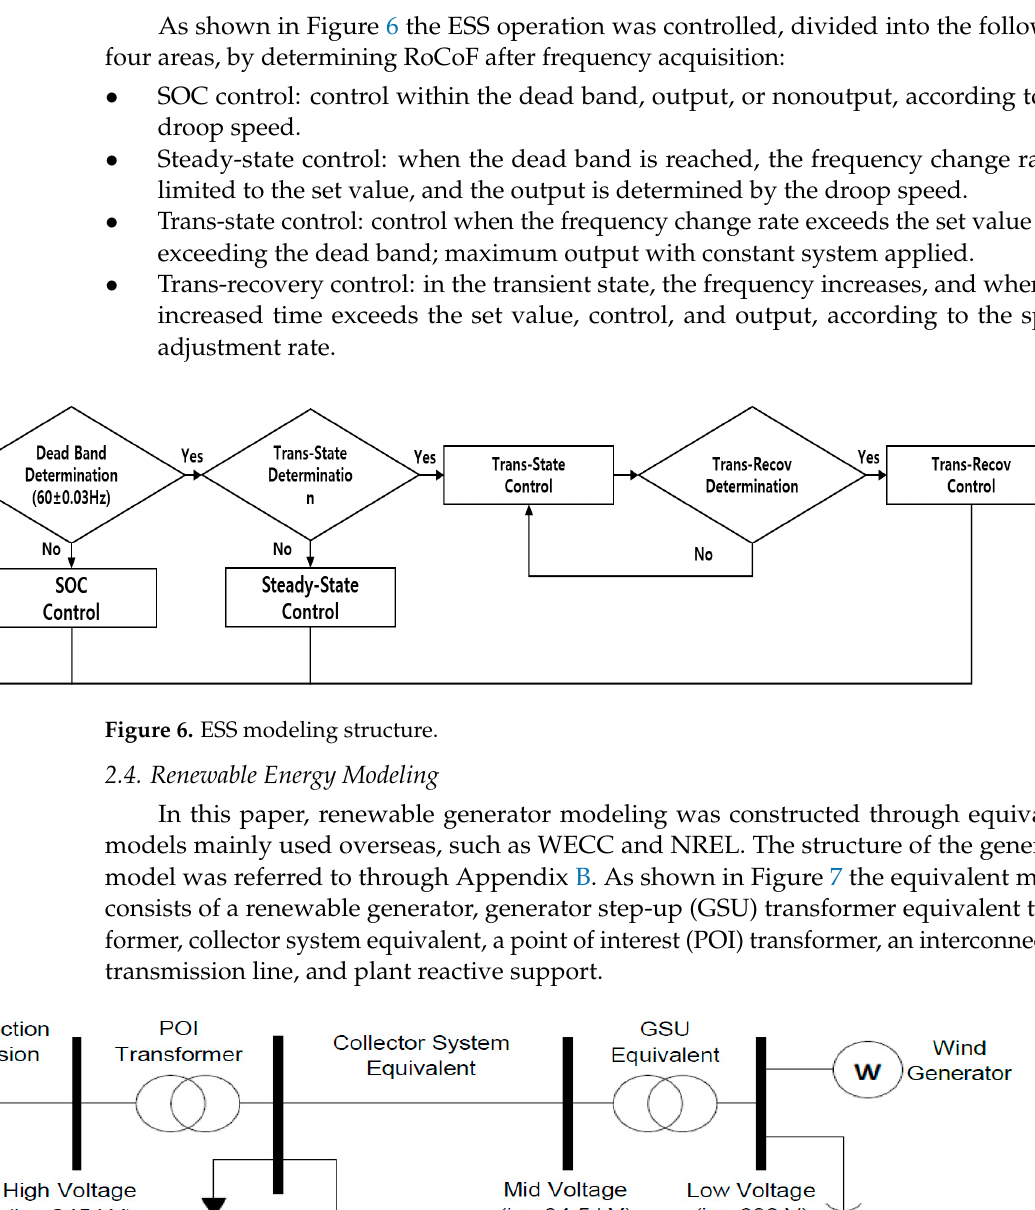
Figure 5. ESS Modeling Example.